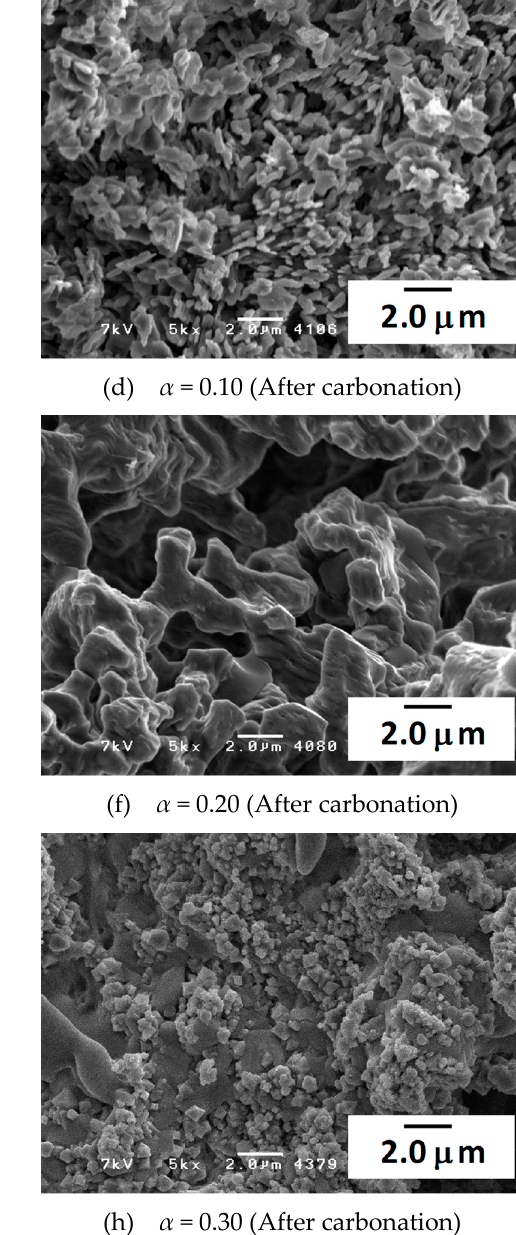
Figure 7. SEM images of materials ( α = 0.05, 0.10, 0.20, and 0.30) before and after carbonation at 350 °C for 300 min.